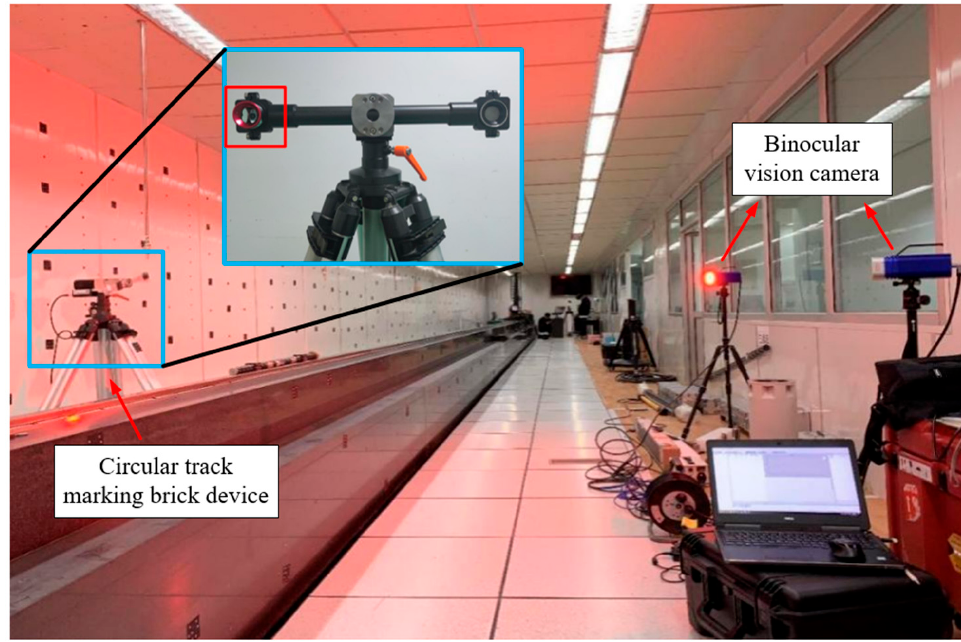
Figure 6. Circular dynamic parameter calibration test.